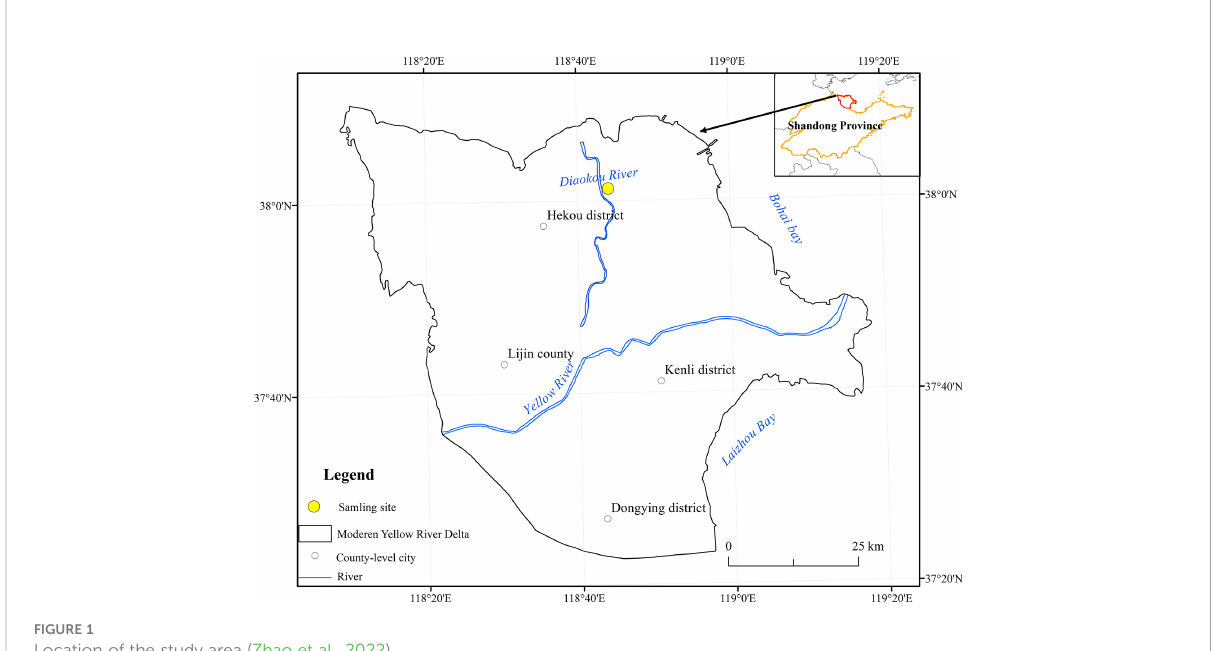
FIGURE 1 Location of the study area (Zhao et al.,